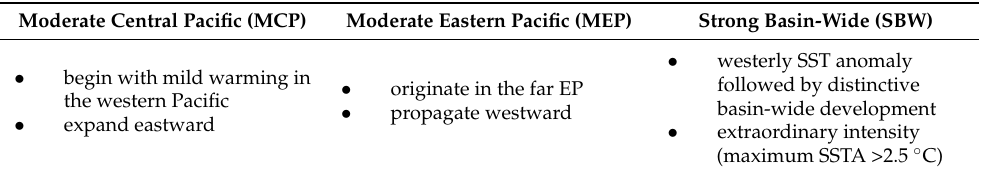
Table 1. Main properties of moderate central Pacific (MCP), moderate eastern Pacific (MEP), and strong basin-wide (SBW) ENSO